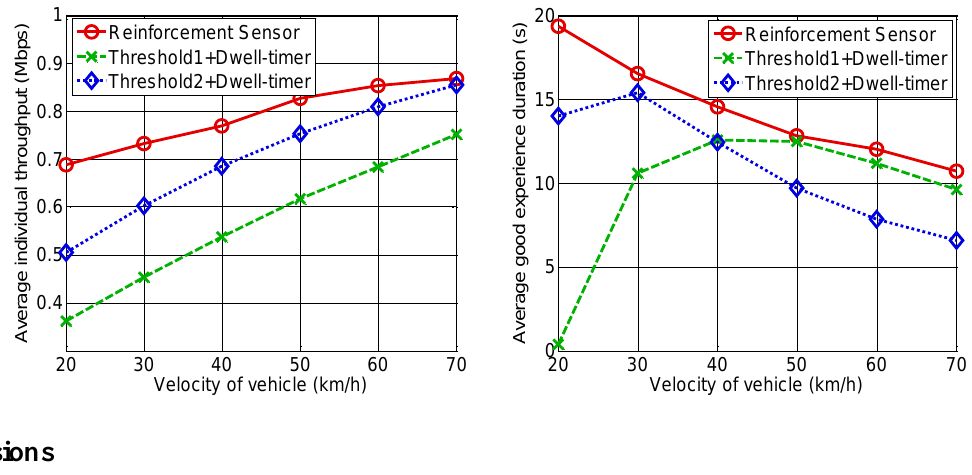
Figure 14. Average individual throughput and good experience duration vs. velocity of vehicle (arrival rate = 0.3